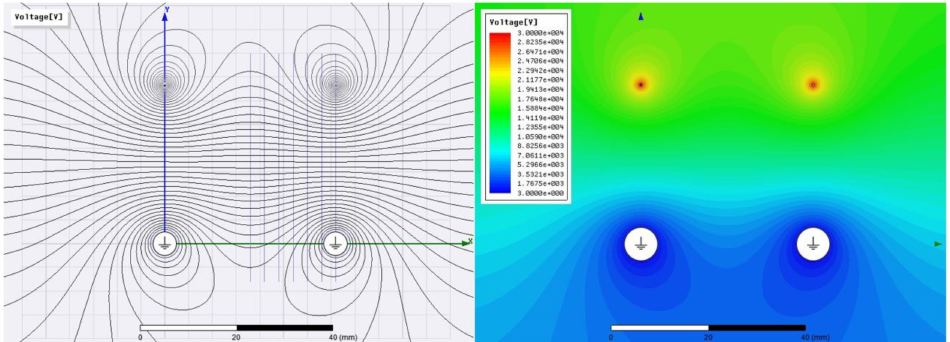
Figure 10. Dual thruster, potential distribution between emitter and collector.